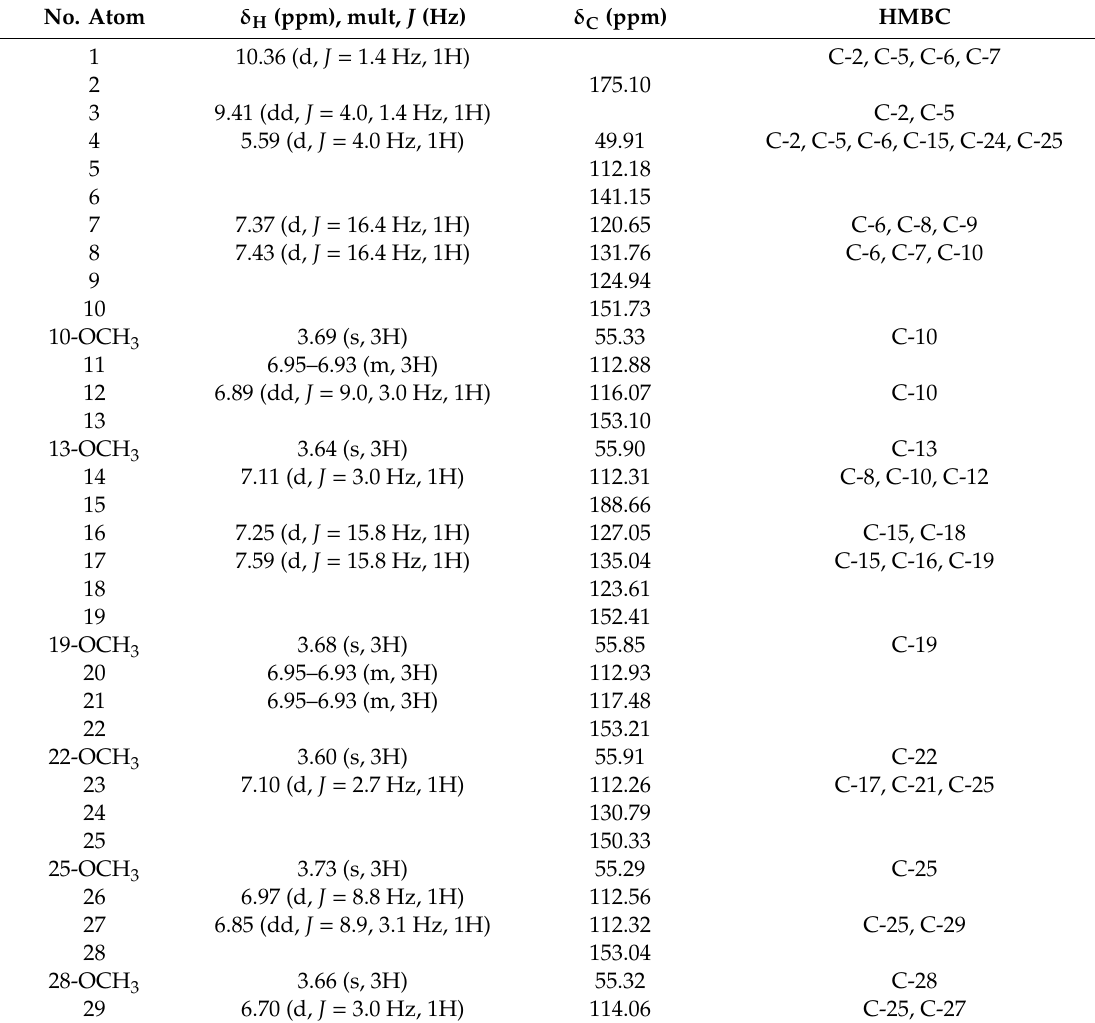
Table 3. NMR data of compound 6 in DMSO- d 6